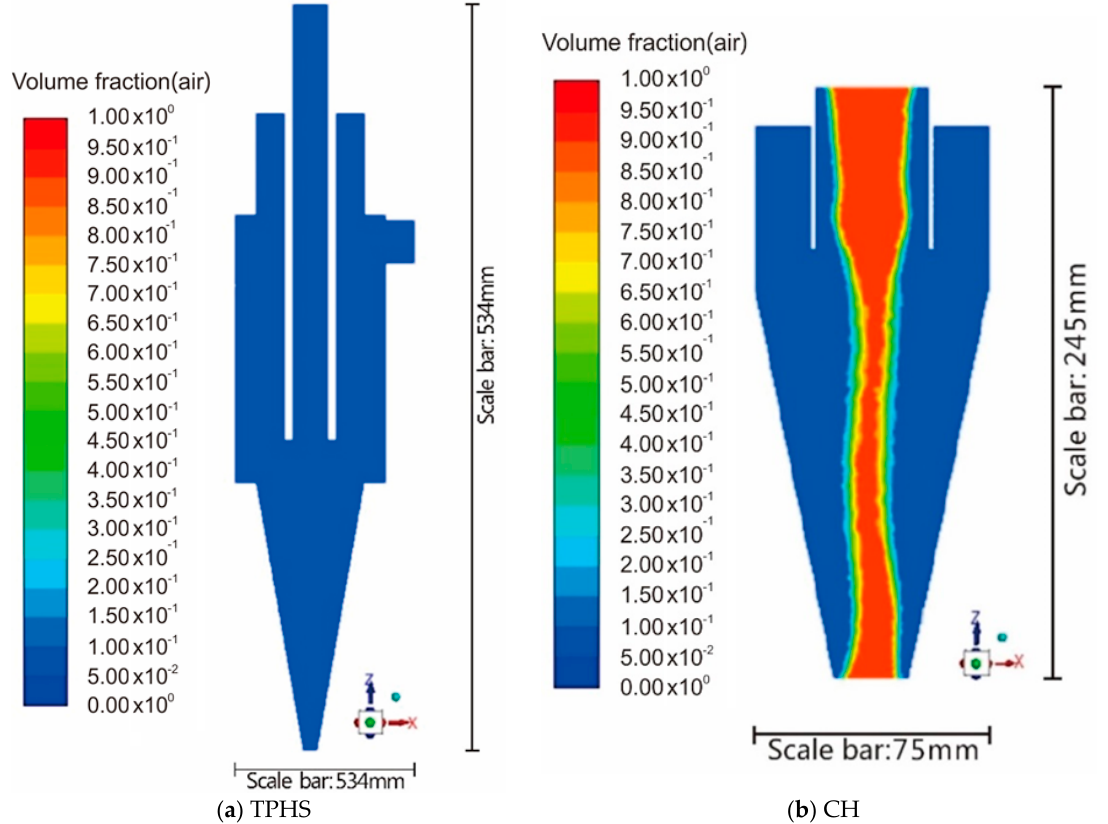
Figure 7. Contours of air volume fraction at plane y = 0 mm with the inlet velocity of 5 m/s at the simulation time of 10 s: ( a ) TPHS, ( b ) CH.